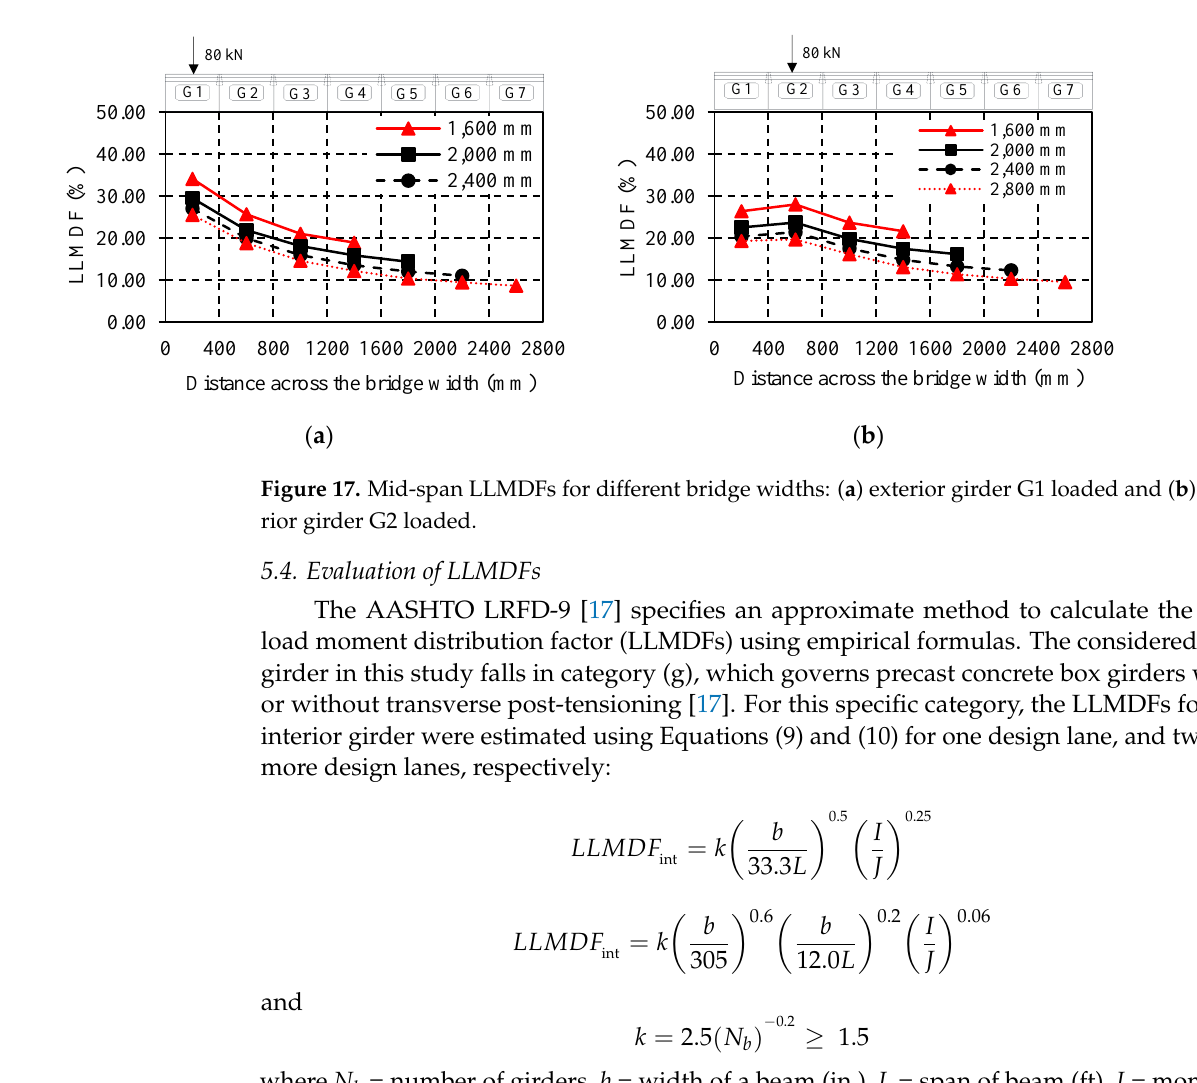
Figure 16. Mid-span deflection profile for different bridge widths: ( a ) exterior girder G1 loaded and ( b ) interior girder G2 loaded.